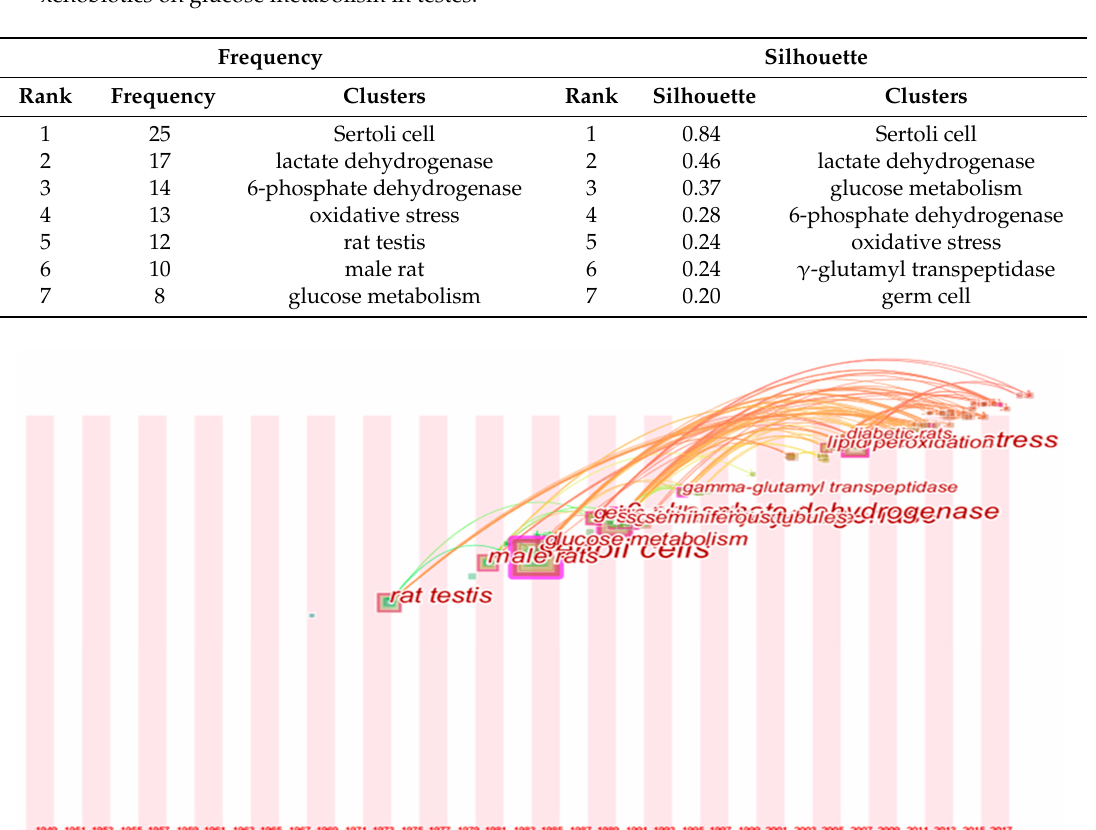
Figure 5. Timeline view for co-words analysis.